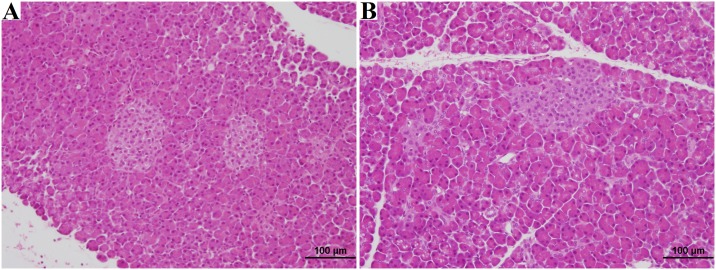
Pancreas H&E analysis.Biopsy A shows H&E of naïve rhesus, age 21 years, diagnosed mild apoptosis, minimal lobular atrophy. Biopsy B shows H&E of brain dead rhesus, age 17 years, diagnosed mild apoptosis, minimal lobular atrophy.